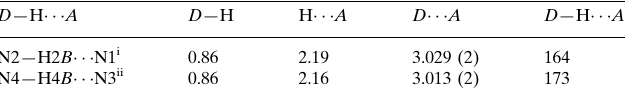
Hydrogen-bond geometry (A˚ , (cid:2)